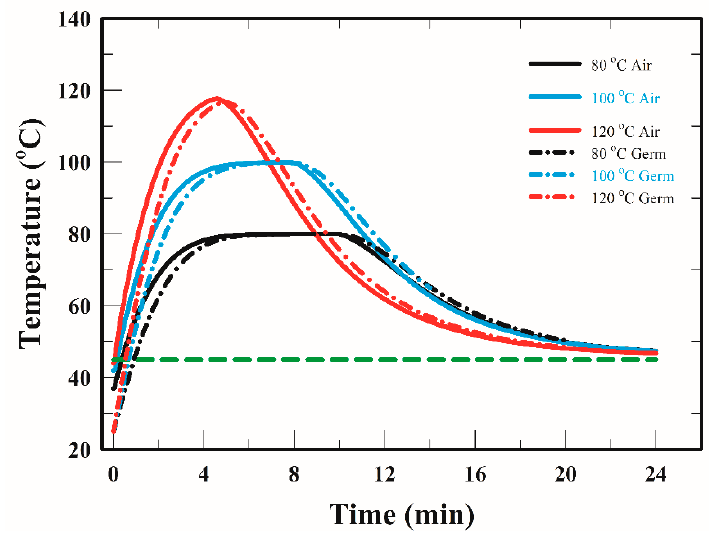
Figure 6. Simulated profiles of the air temperature and WG temperature during drying in the FBD at different set temperature. Solid lines represent the air temperature; dash-dot lines represent the WG temperature; the dashed line represents the product temperature of 45 °C.